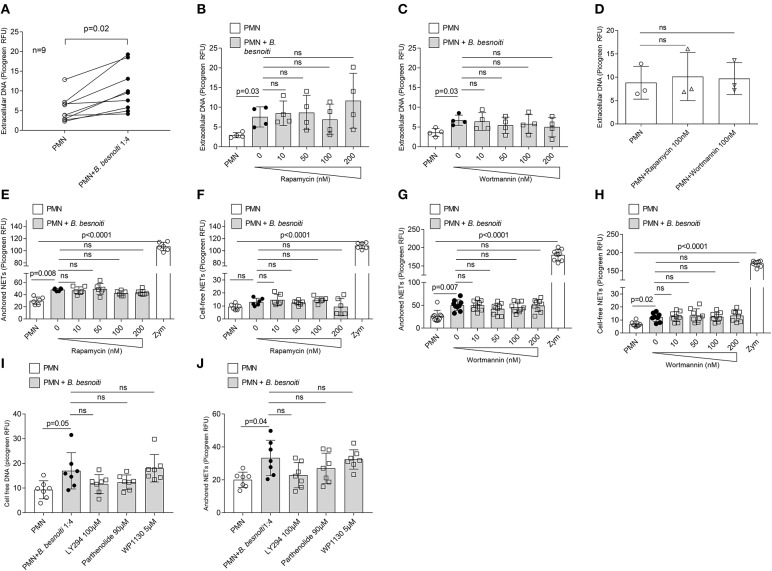
Effects of rapamycin and wortmannin treatments on Besnoitia besnoitia-triggered NET formation as detected by PicoGreen-based quantification. Bovine PMN were pre-treated with increasing concentrations of rapamycin and wortmannin for 30 min and then exposed to B. besnoiti tachyzoites for 3 h. After incubation, the samples were analyzed as follows. (A–D) samples were treated with micrococcal nuclease for 15 min, thereafter centrifuged and extracellular DNA present in the supernatants were analyzed using PicoGreen-based quantification. (E–H) samples were centrifuged immediately and the supernatants were analyzed for “cell free” NETs. Moreover, remaining pellets located at the bottom were investigated for “anchored” NETs. For both approaches, extracellular DNA was detected and quantified via PicoGreen-derived fluorescence intensities. In all assays, zymosan treatments (1 mg/ml) were used for positive controls. Statistical analyses were performed by Kruskal-Wallis test followed by Dunn's test for multiple comparisons. p-values are indicated in the graphs (Mean ± SD).